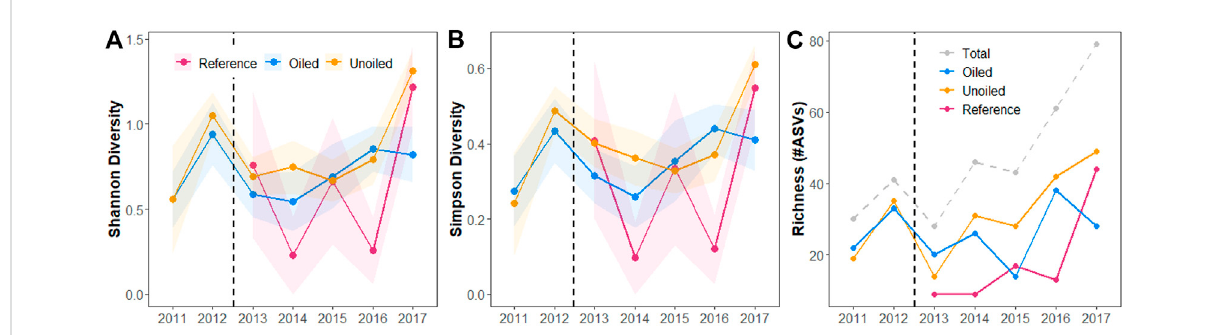
FIGURE 3 Diversity and richness trends in Seaside Sparrow diet over time. In fi gures (A,B) , points represent population means and shading represent ±1 standard error. In fi gure (C) , the total number of ASVs detected per year is represented by the gray dashed line, but note that duplicate ASVs are only counted once in the overall total richness. For example, an ASV detected in both oiled and unoiled sites would only be counted once toward the total ASVs in a year. The dashed black line in all fi gures represents the approximate time of Hurricane Isaac making